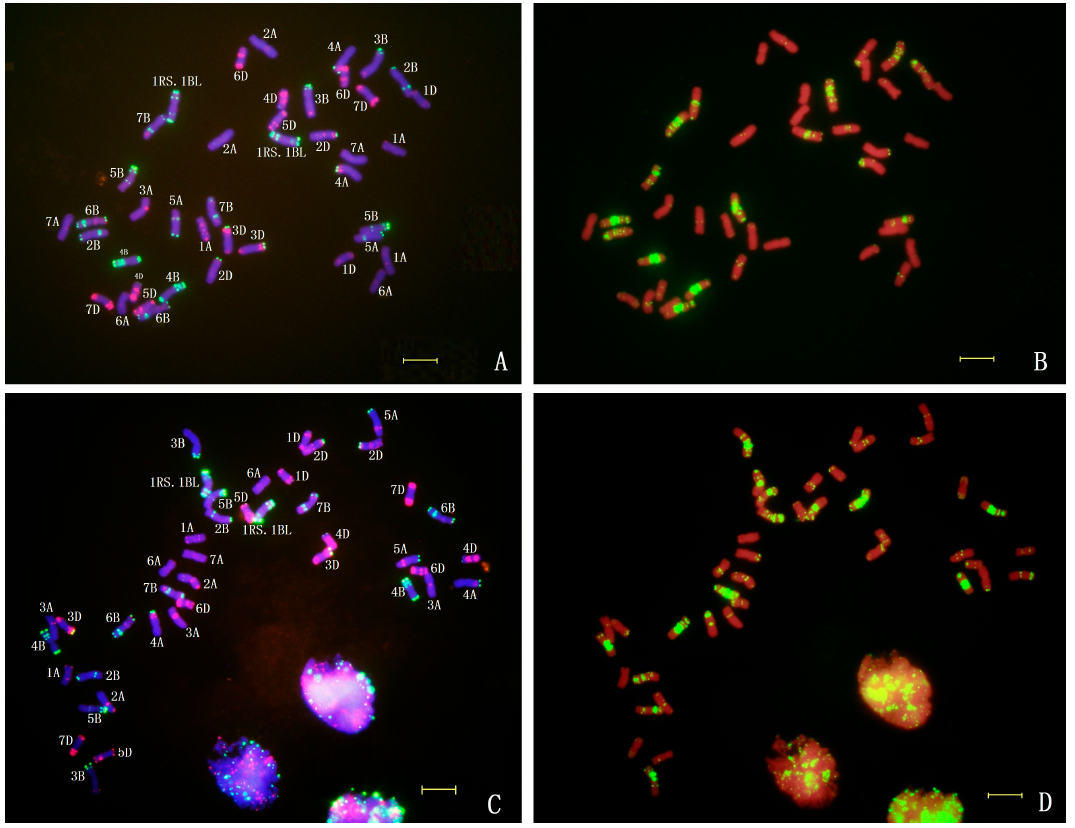
Figure 2. Fluorescence in situ hybridization (FISH) of SW1862 ( A , B ) and Chuanmai45 (CH45) ( C , D ) with ( A , C ) stained by DAPI (blue), Oligo-pTa535 (red), and Oligo-pSc119.2 (green), ( B , D ) stained by PI (red) and Oligo-(GAA) 7 (green).Scale bar indicates 10 μ m. Table 3. Co-segregation of chromosome 1RS with rust resistance of F 2 plants from the cross of CH45/CH42 tested against stripe rust pathotype No. 09-6-16-3.